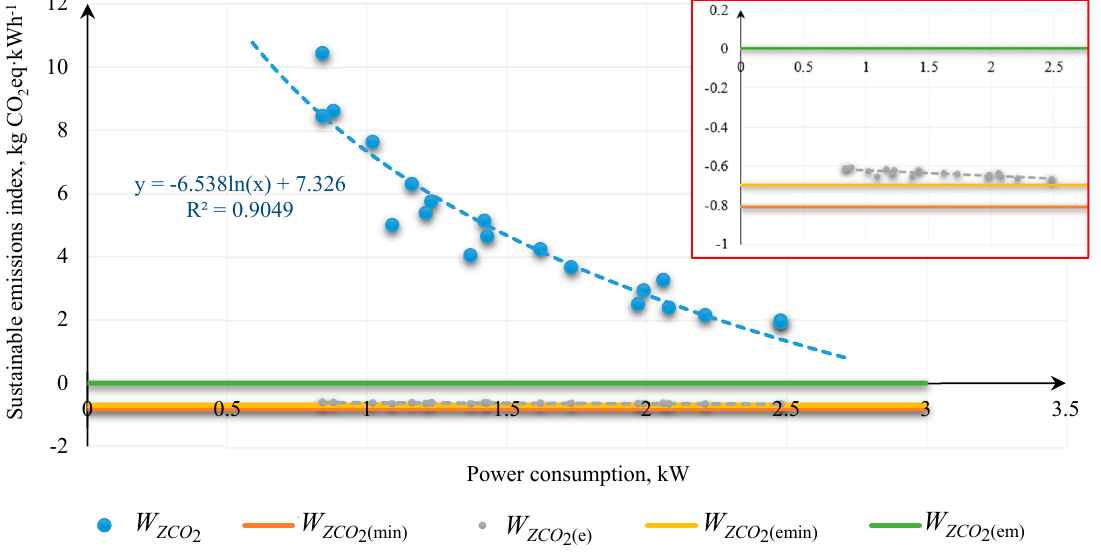
Figure 6. Sustainable CO 2 emissions index for rice grinding on a multi-disc grinder in a function of power input.